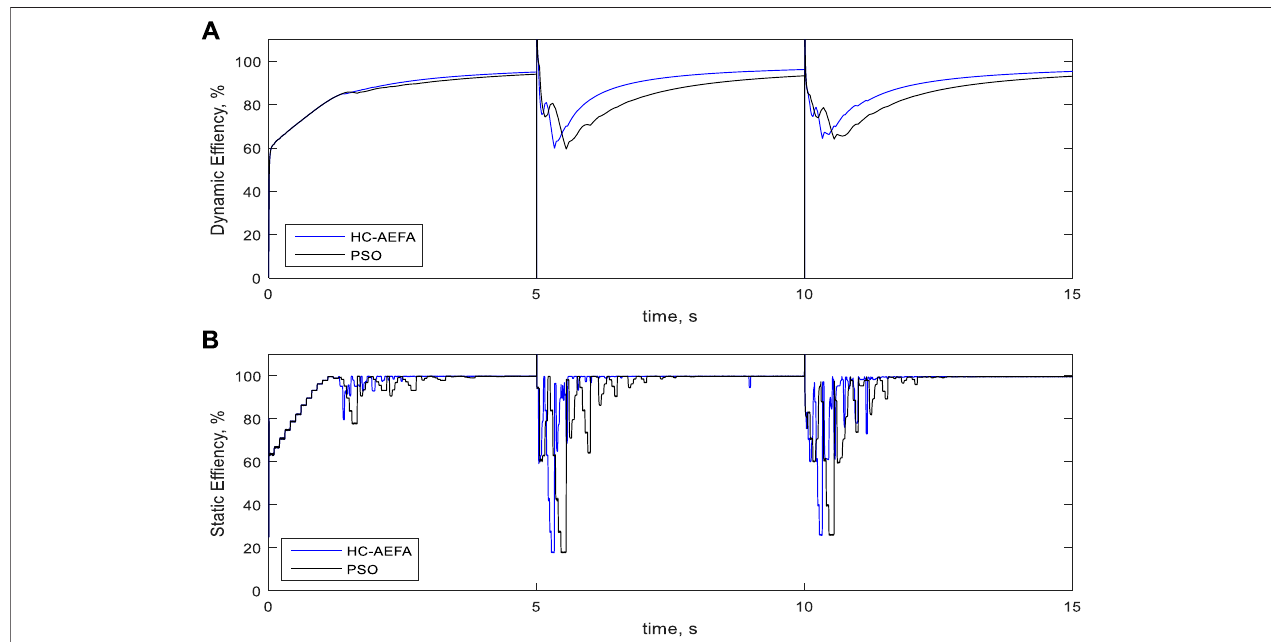
FIGURE 14| Ef fi ciency curvesat the fourth patternobtained using the HC-AEFA, HC, AEFA, and PSO methods; (A) Dynamic- ef fi ciency, and (B) Static-ef fi ciency.